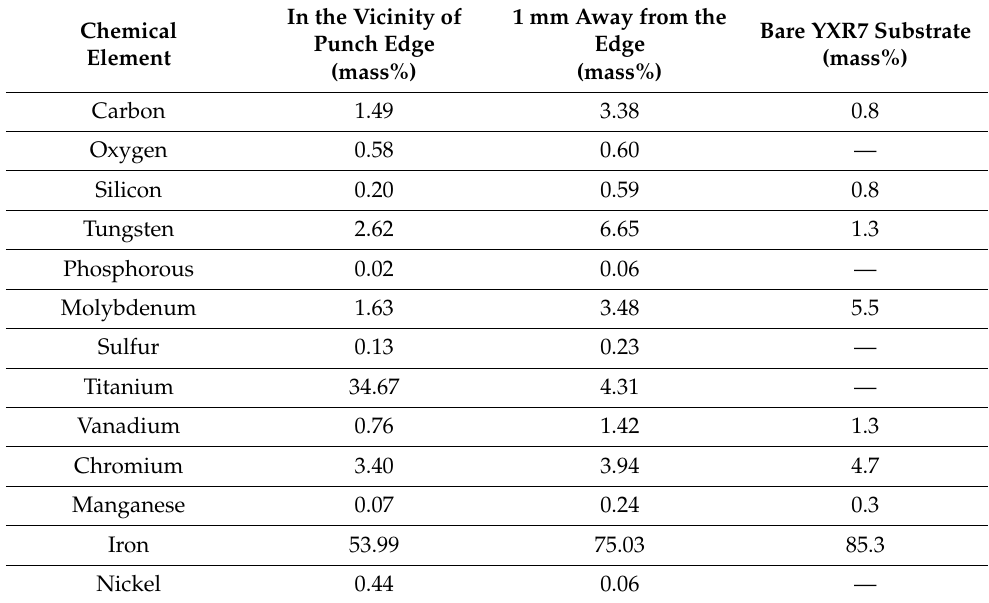
Table 1. Comparison of the chemical compositions analyzed in the vicinity of the edge and at a position 1 mm away from the punch edge at the contact interface between the CS-YXR7 punch and the titanium work material, with reference to the chemical compositions of the bare YXR7. In the Vicinity of Chemical Punch Element